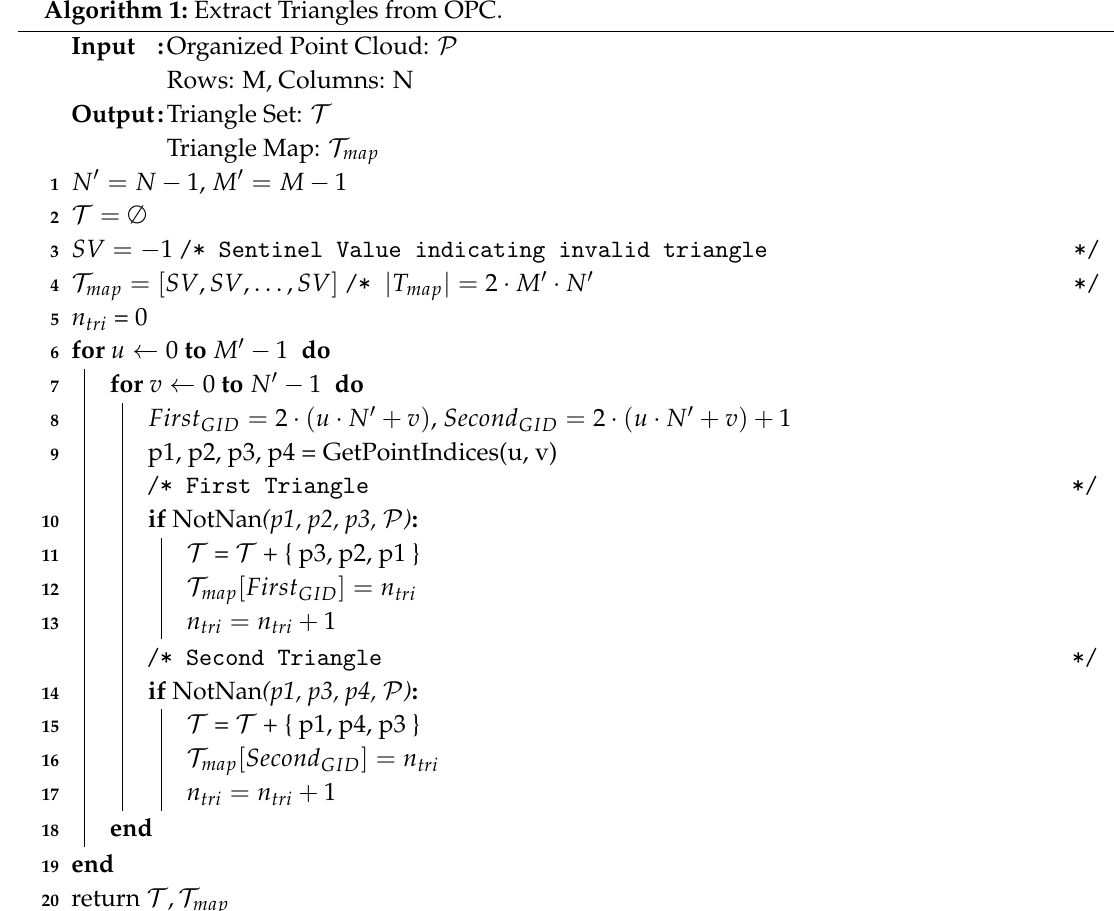
Algorithm 1: Extract Triangles from